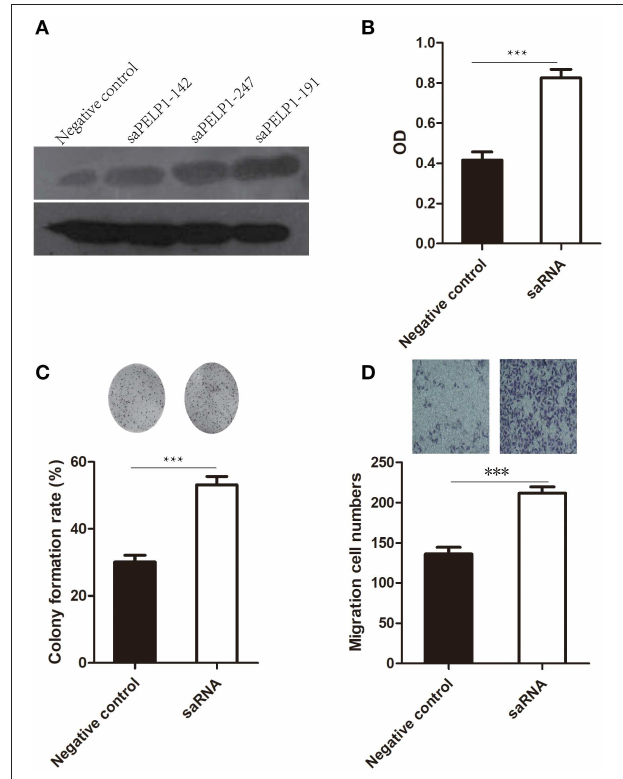
FIGURE 3 | PELP1 activation promoted proliferation, colony formation, migration of GES-1 in vitro . (A) Representative image of western blot for testing the activation effect of saRNA to PELP1 in GES-1. (B) saRNA for PELP1 increased the proliferation ability of GES-1. (C) saRNA for PELP1 increased the colony formation ability of GES-1. (D) saRNA for PELP1 increased the invasion ability of GES-1. *** p <